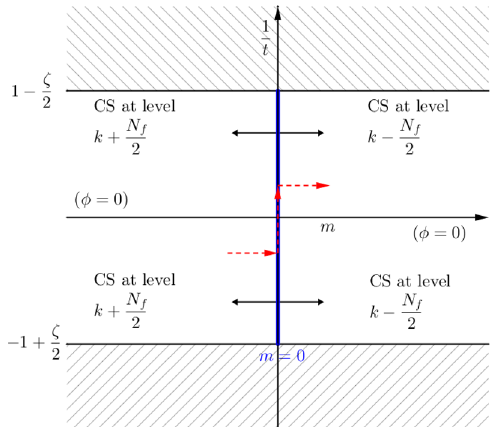
Figure 6 . Phases diagram of the theory with N f hypermultiplets all of mass m at λ → ±∞ , in the (cid:0) (cid:1) -plane. In the shaded region the matrix model is ill-defined. Crossing the blue wall m, 1 t the theory undergoes a third order phase transition, indicated by the solid, black arrows in the picture. The dashed, red arrows indicate a phase transition between the two non-trivial regions.